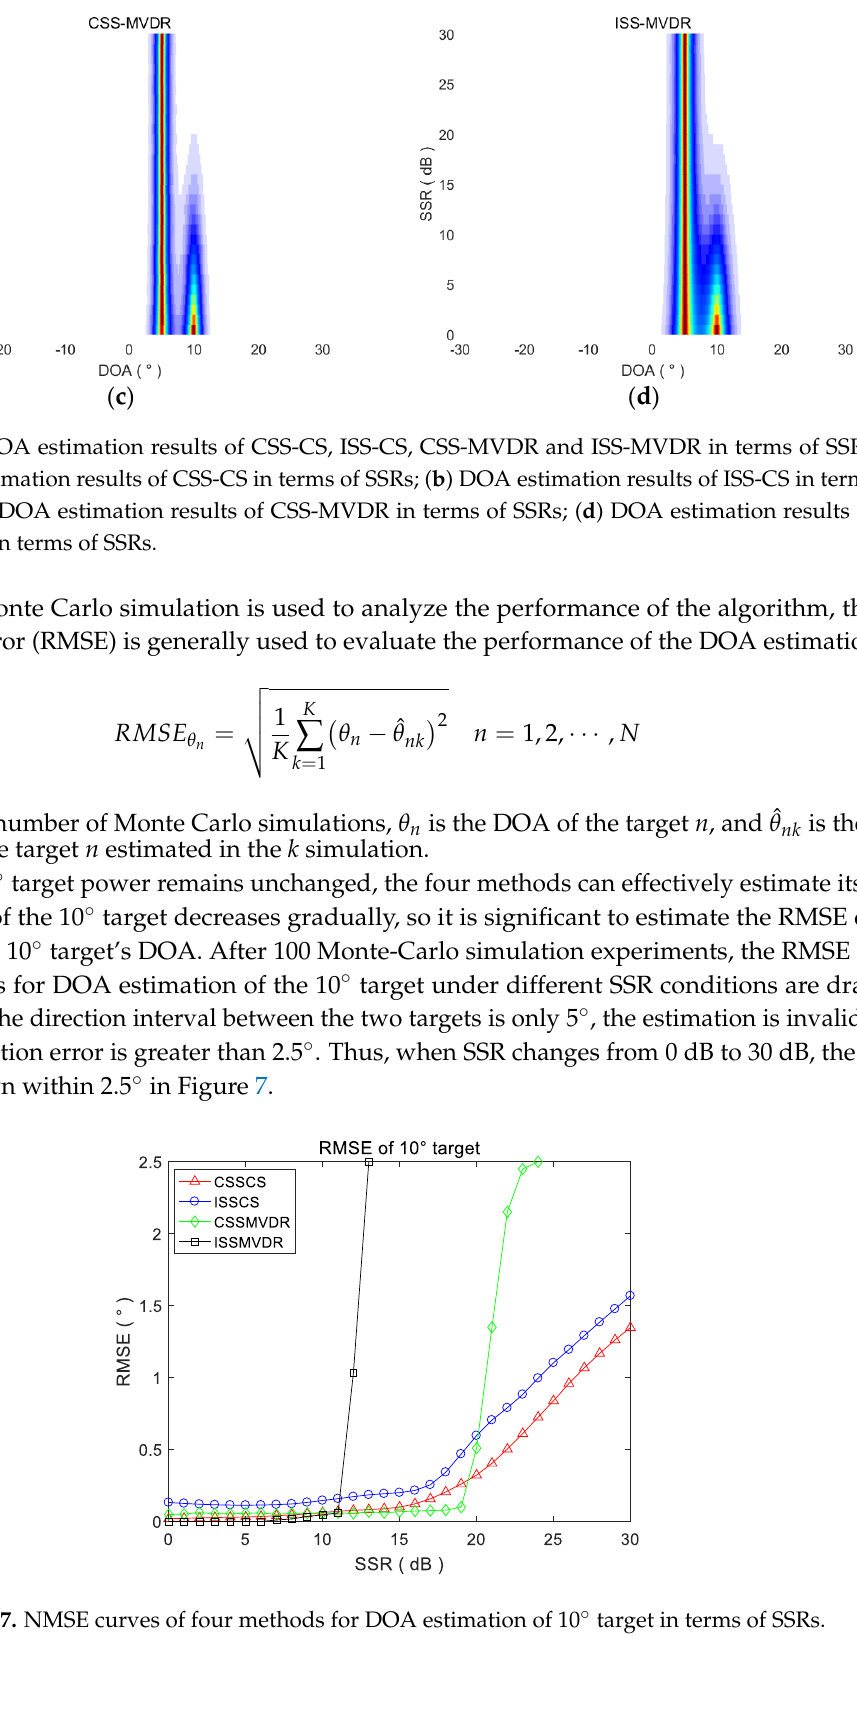
Figure 7. NMSE curves of four methods for DOA estimation of 10° target in terms of SSRs.